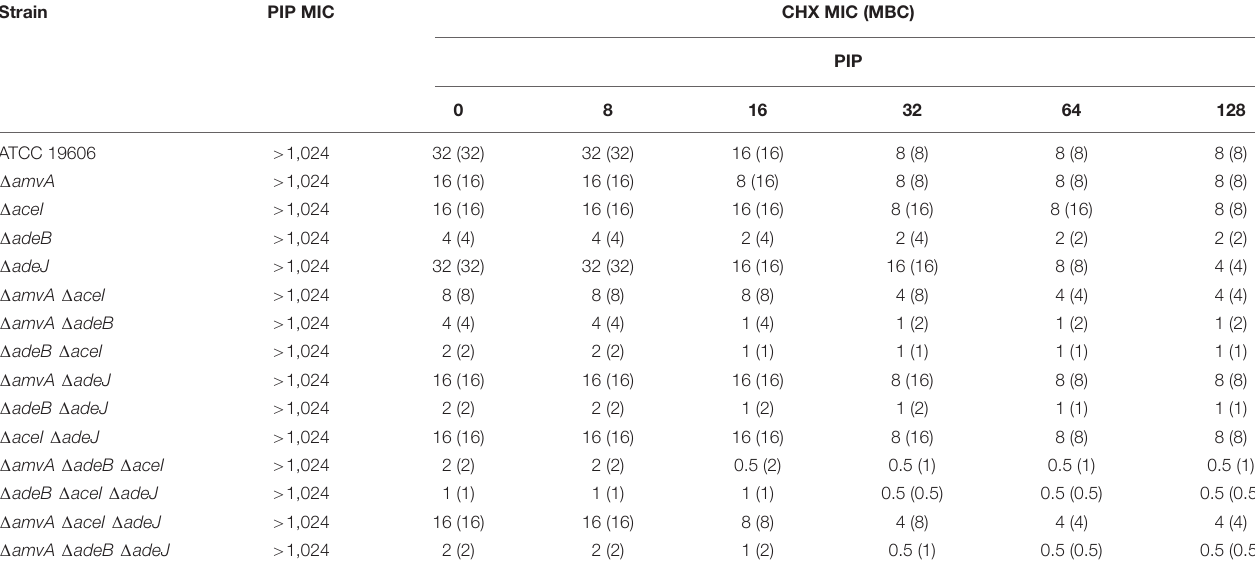
TABLE 5 | MIC (mg/L) and MBC of CHX (mg/L) in combination with PIP in A. baumannii ATCC 19606 parental strain and EP deletion mutants. Strain PIP MIC